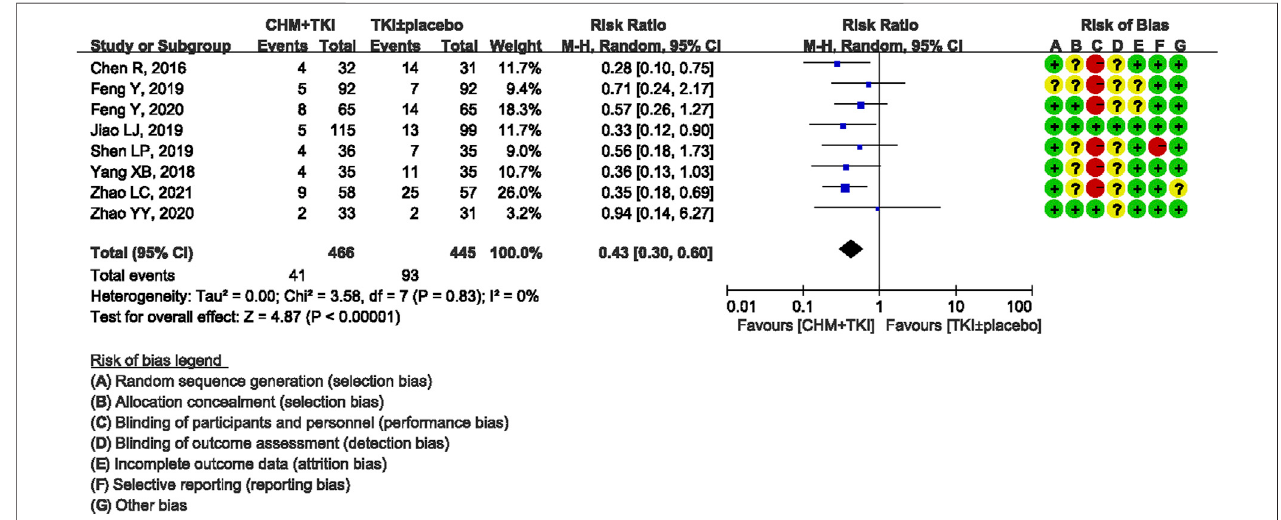
FIGURE 7 | Forest plot on incidence of